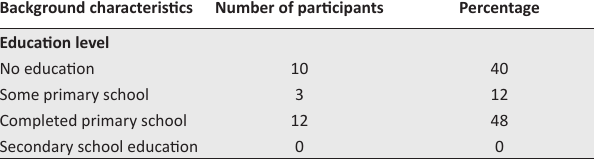
TABLE 5: Pregnant women ’ s education level.